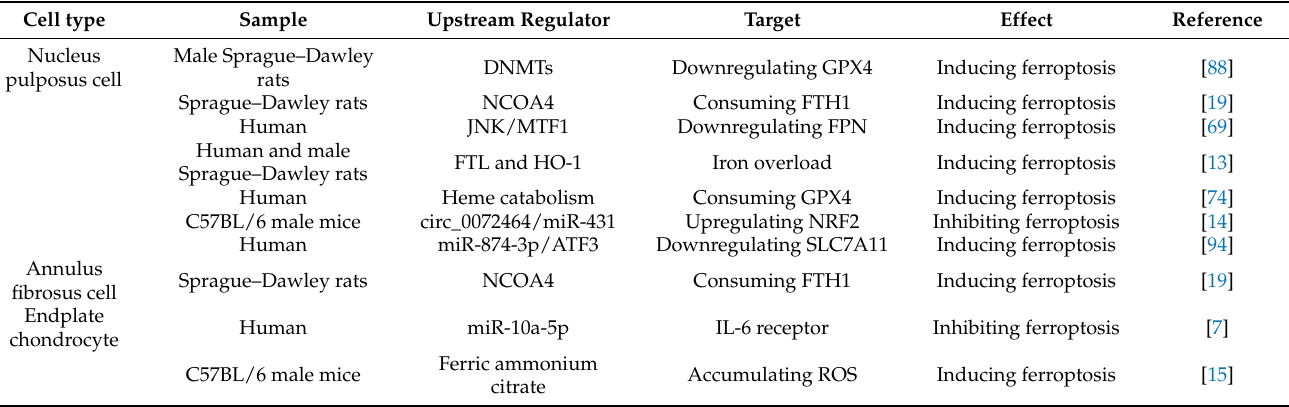
Table 1. Ferroptosis in intervertebral disc